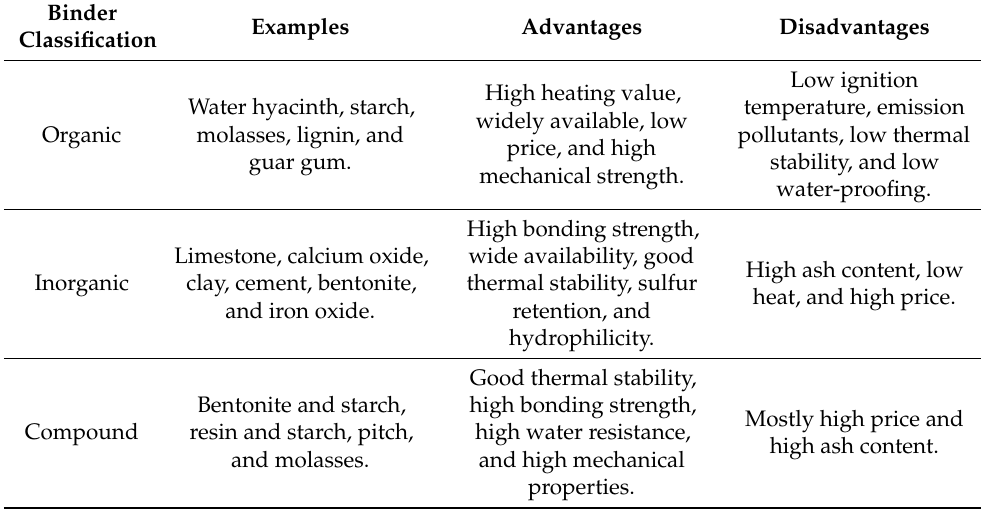
Table 2. An overview of the binder types and their characteristics